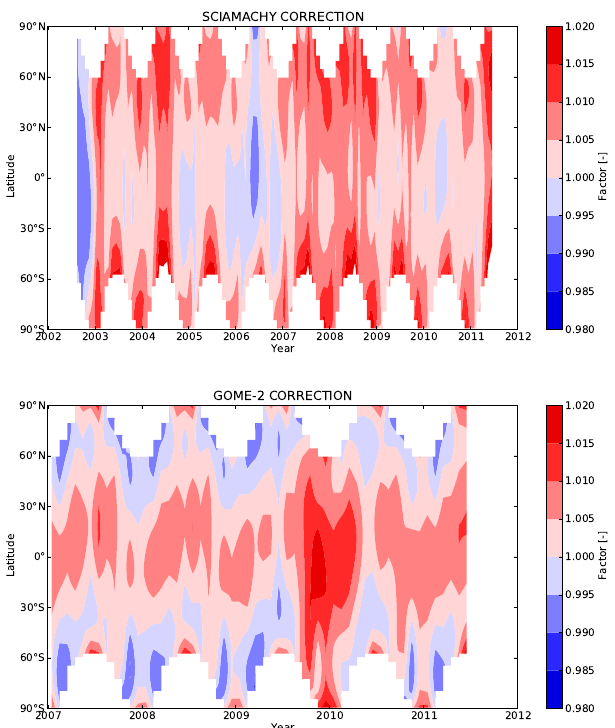
Figure 1. Correction factors for SCIAMACHY 2002–2011 (top panel) and GOME-2A 2007–2011 (bottom panel) as a function of latitude.